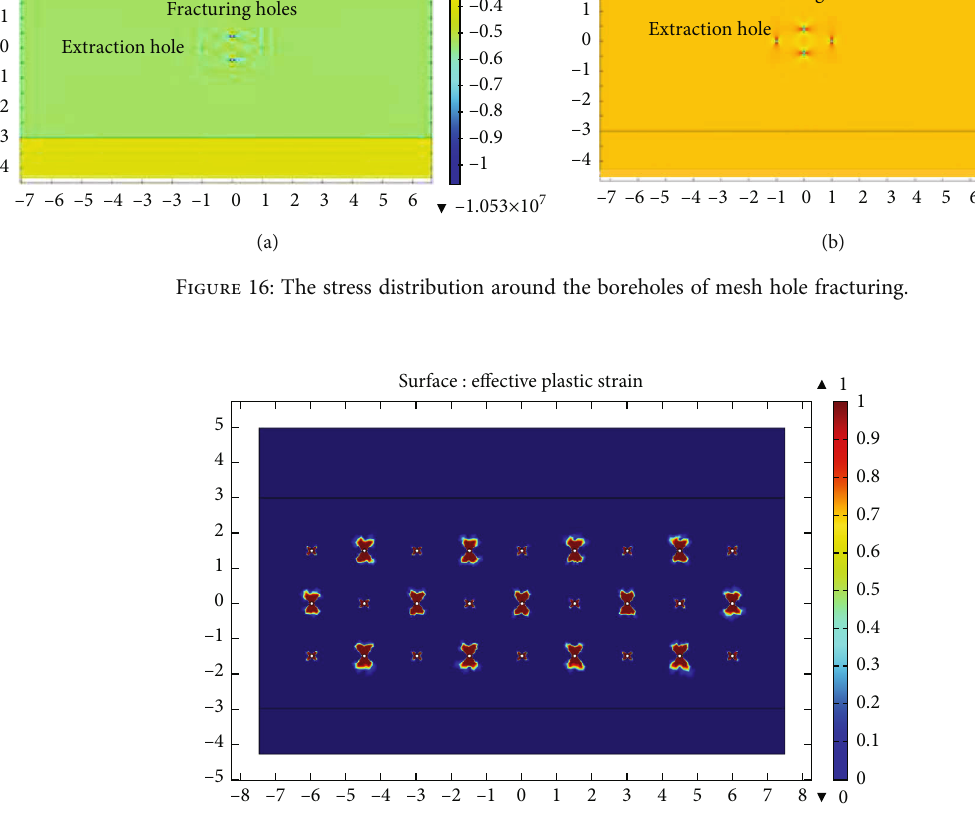
Figure 17: Distribution of plastic zone in boreholes after fracturing with mesh